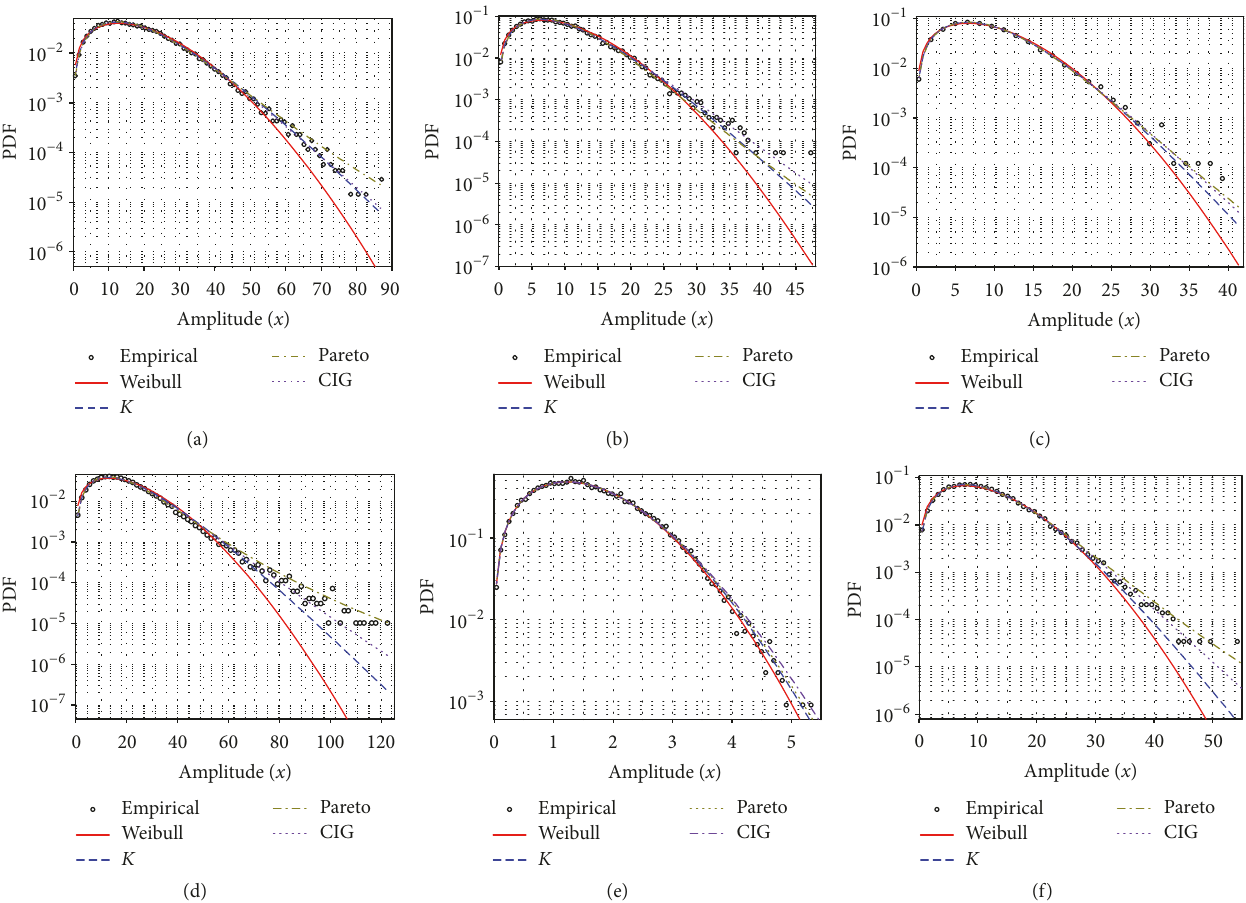
Figure 4: Examples of the fitted PDFs for DS2: ((a)–(c)) sum channel and the elevation and azimuth difference channels for the 200th range cell. ((d)-(e)) Sum channel and the elevation and azimuth difference channels for the 380th range cell.